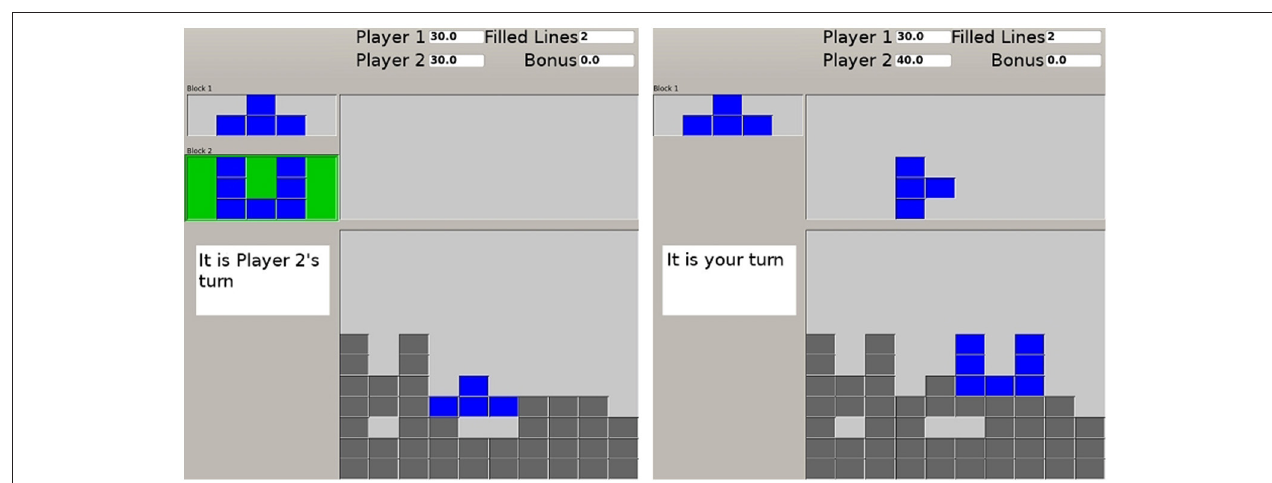
Frontiers in Digital Humanities |